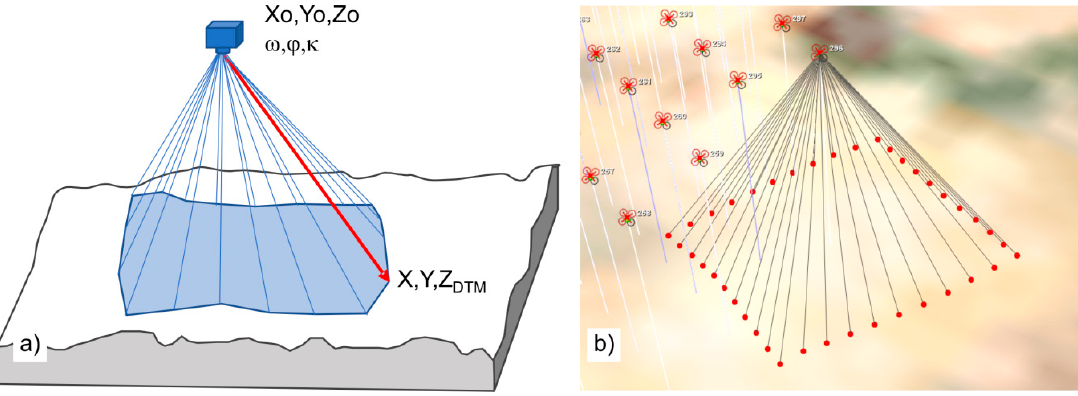
Figure 3. ( a ) Forward ray casting method and ( b ) application to a real case using MFPlanner3D.